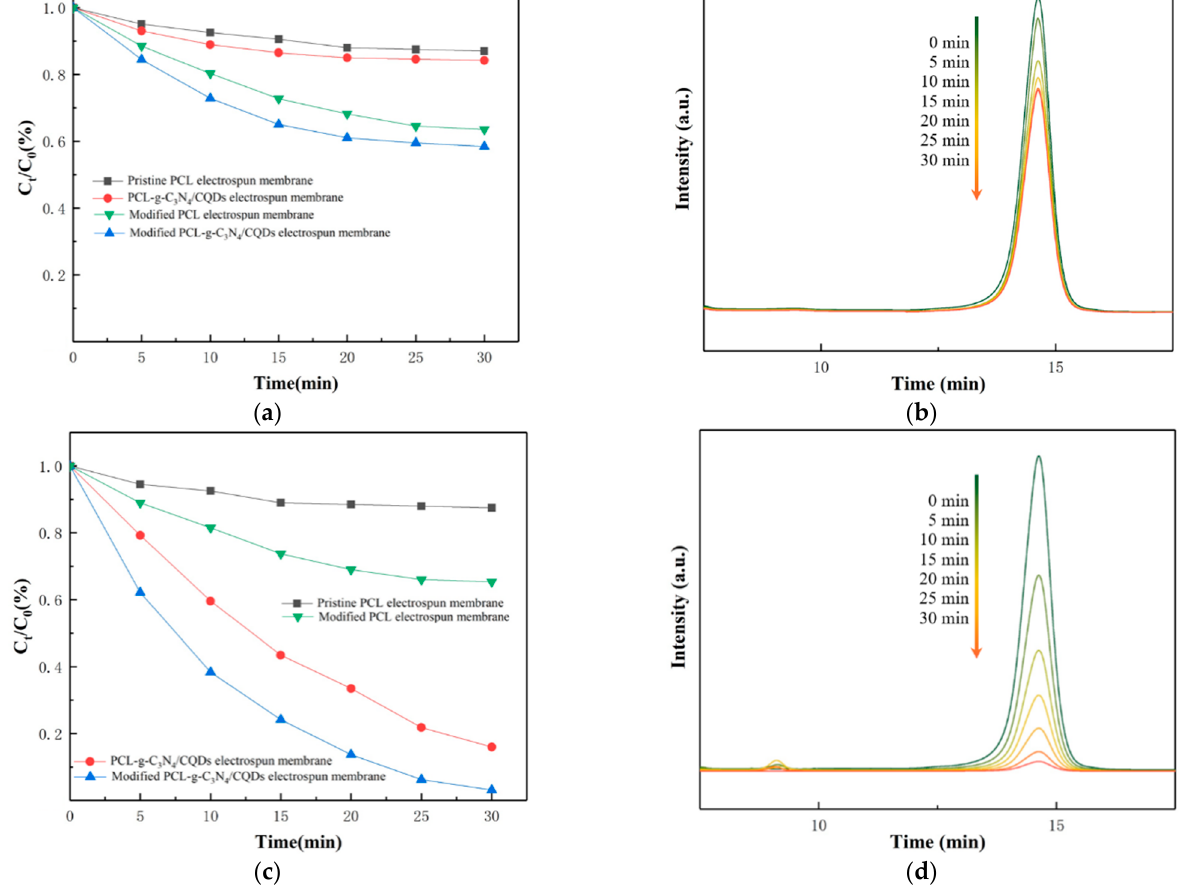
Figure 8. ( a ) Adsorption-removal performances of AFB 1 with the four kinds of membranes under dark. ( b ) HPLC chromatogram of AFB 1 adsorption-removal with modified PCL-g-C 3 N 4 /CQDs electrospun membranes under dark at different times. ( c ) Synergistic adsorption and photocatalytic degradation performance of AFB 1 with the four kinds of membranes under visible light irradiation. ( d ) HPLC chromatogram of AFB 1 adsorption and photocatalytic degradation with modified PCL-g- C 3 N 4 /CQDs electrospun membranes under visible light irradiation at different times.